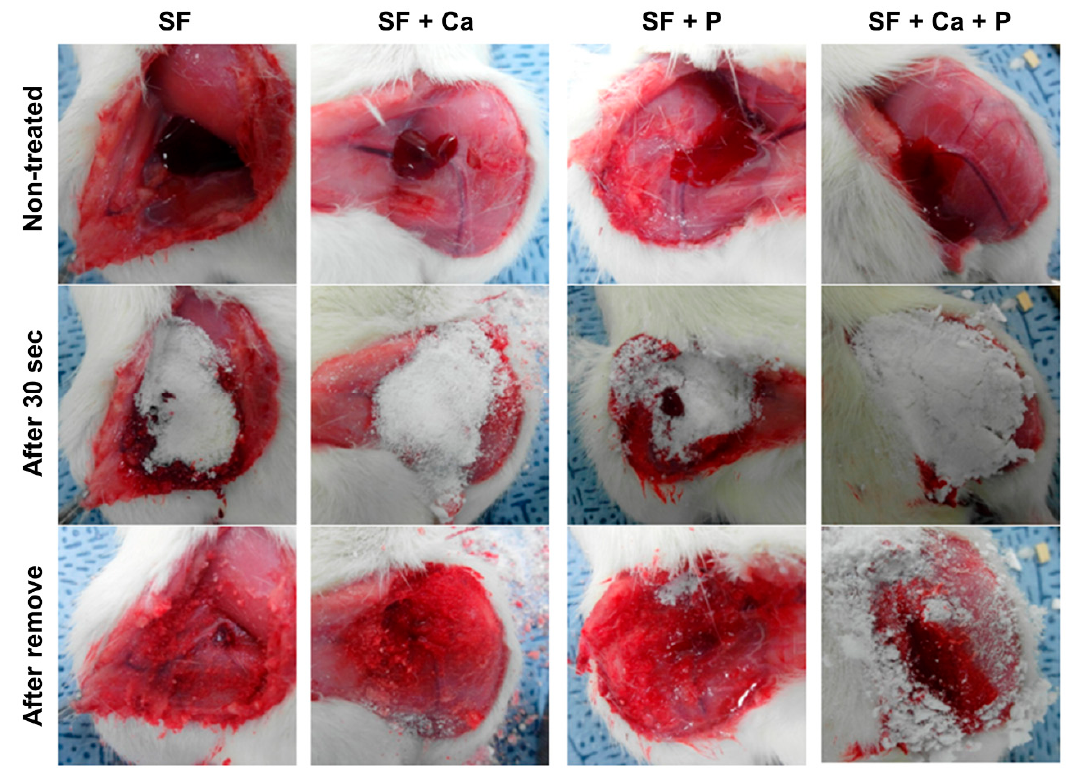
Figure 3. In vivo hemostasis of the SF-based powder using the femoral vein incision of the rat. After the femoral vein incision, SF-based powders were applied to stop bleeding for 30 s. Unpublished data.